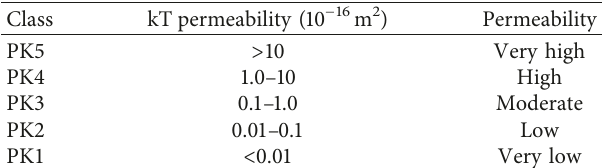
Figure 7: Coefficients of permeability to air in constructive ele- ments for house cover. Zinc sheet, roofing tile from recycled materials (CEVE), concrete roofing tile with terracotta pigment integral with water-based resin, ceramic roofing tile unglazed colonial, and ceramic roofing tile unglazed French have a kT value close to Table 3: Classification of concrete roofing tiles according to the coefficients of permeability to air (Swiss Standard SIA 262/1-E10).